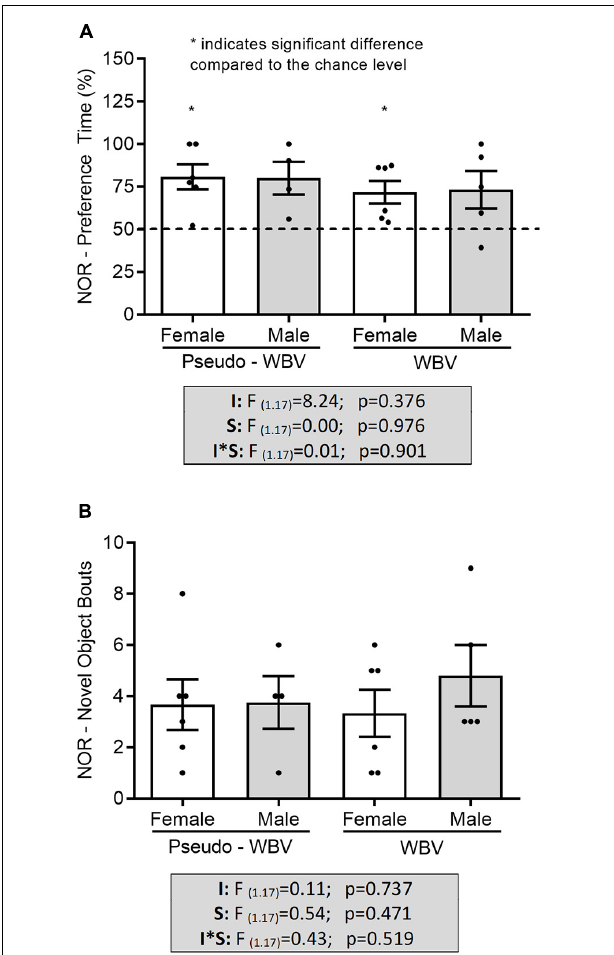
FIGURE 5 | Effects of whole body vibration on object memory in the novel object recognition test. Preference time and number of novel object bouts had no significant difference among all groups (A,B) . Preference time showed significant difference in the female animals compared with the 50% of chance level (A) . Two-way ANOVA was used for the analysis of group interactions, and the independent sample t -test was used for comparison to the chance level. Pseudo whole body vibration ( n = 10, 6 females and 4 males) and whole body vibration ( n = 11, 6 females and 5 males). Dotted line: reference line of 50% for random exploration. F, F statistical value; I, main effect of intervention (vibration/pseudo vibration); S, main effect of sex (male/female); I*S, interaction effect of intervention and sex. Data are depicted as mean ± SEM. * p <